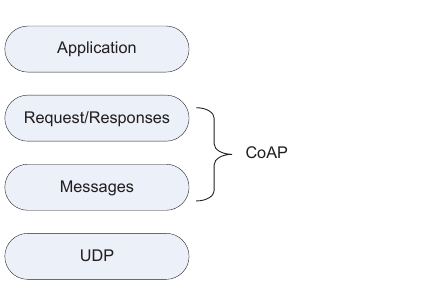
Figure 2. CoAP protocol stack